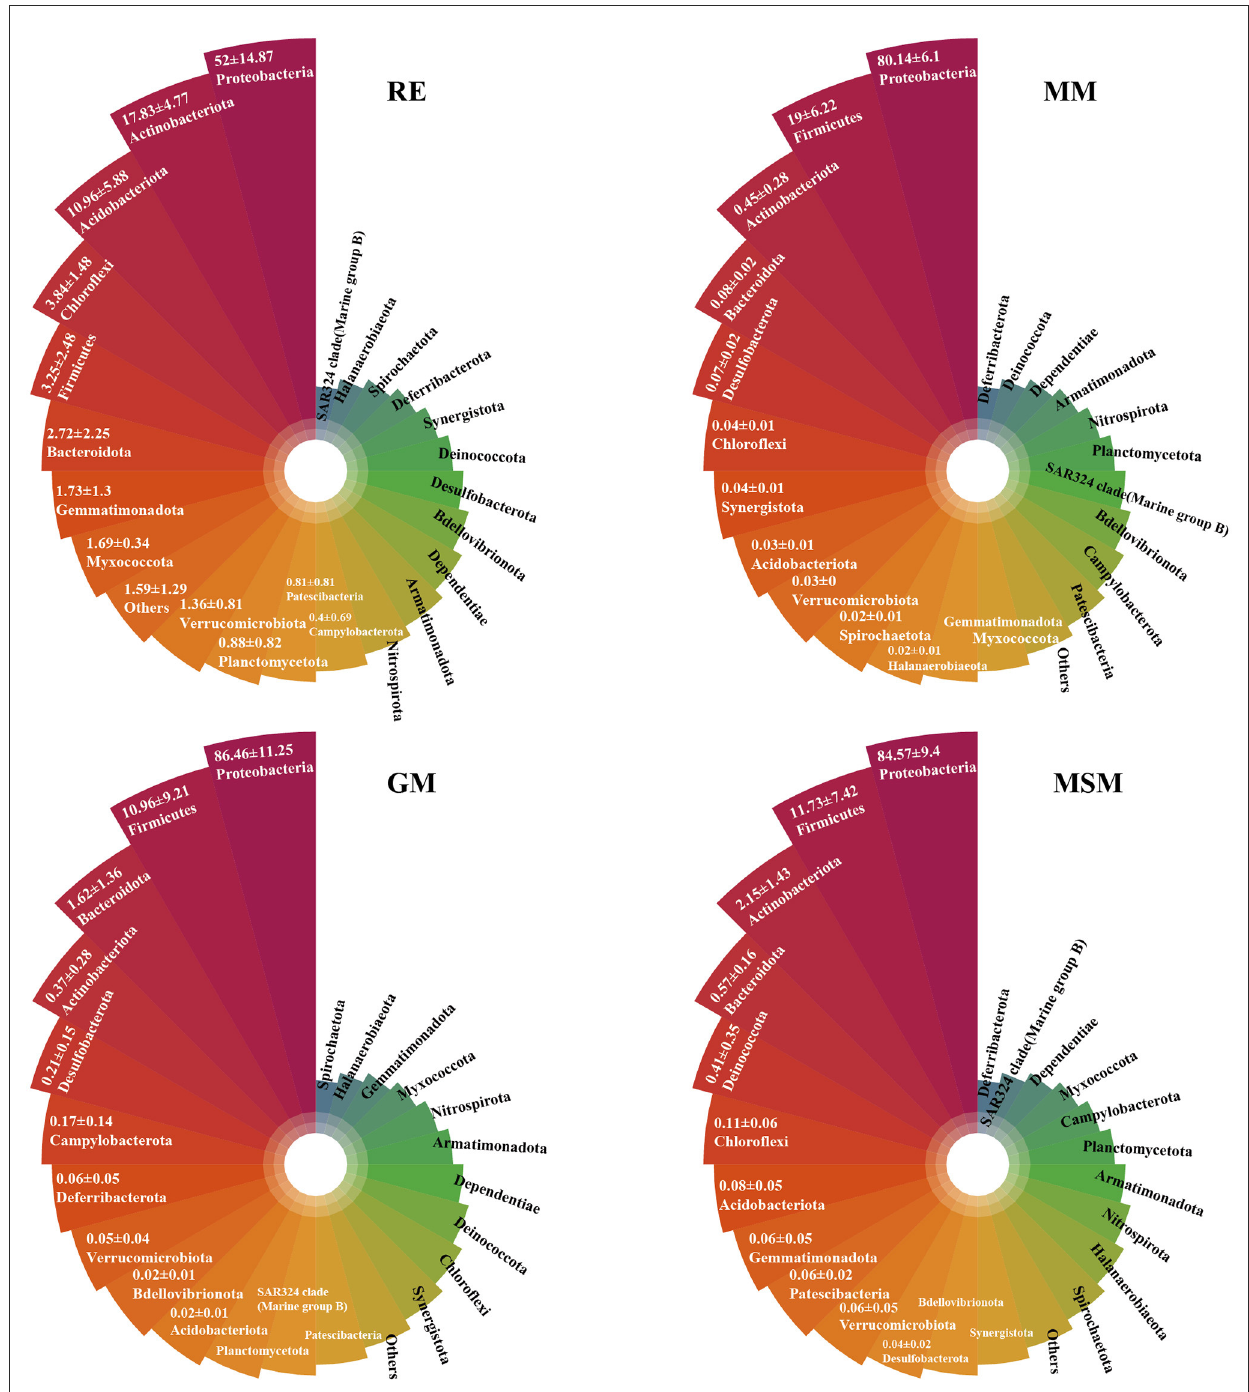
FIGURE3 The upper plots show the top 24 most abundant phyla of bacterial communities in the root tissues and the enrichment collections. Table 1 has a list of abbreviations of the groups used in the